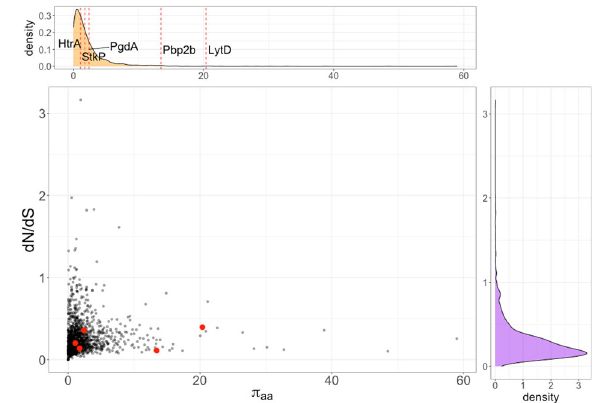
Fig. 2 Selection and diversity in core pneumococcal genes and the selected antigens. Top panel: marginal density distribution of π aa (a measure of the average number of coding changes between a pair of sequences from different isolates) showing the position of the selected antigens with red dashed lines, as labeled. Right panel: marginal density distribution of dN/dS (ratio of non-synonymous to synonymous changes). Central panel: scatter plot of average pairwise sequence diversity π aa vs selection strength for all core genes (black) and tested antigens